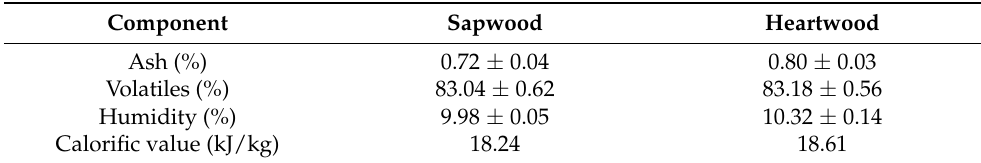
Table 2. Proximate analysis and calorific value of G. triacanthos. Average values with their respective standard